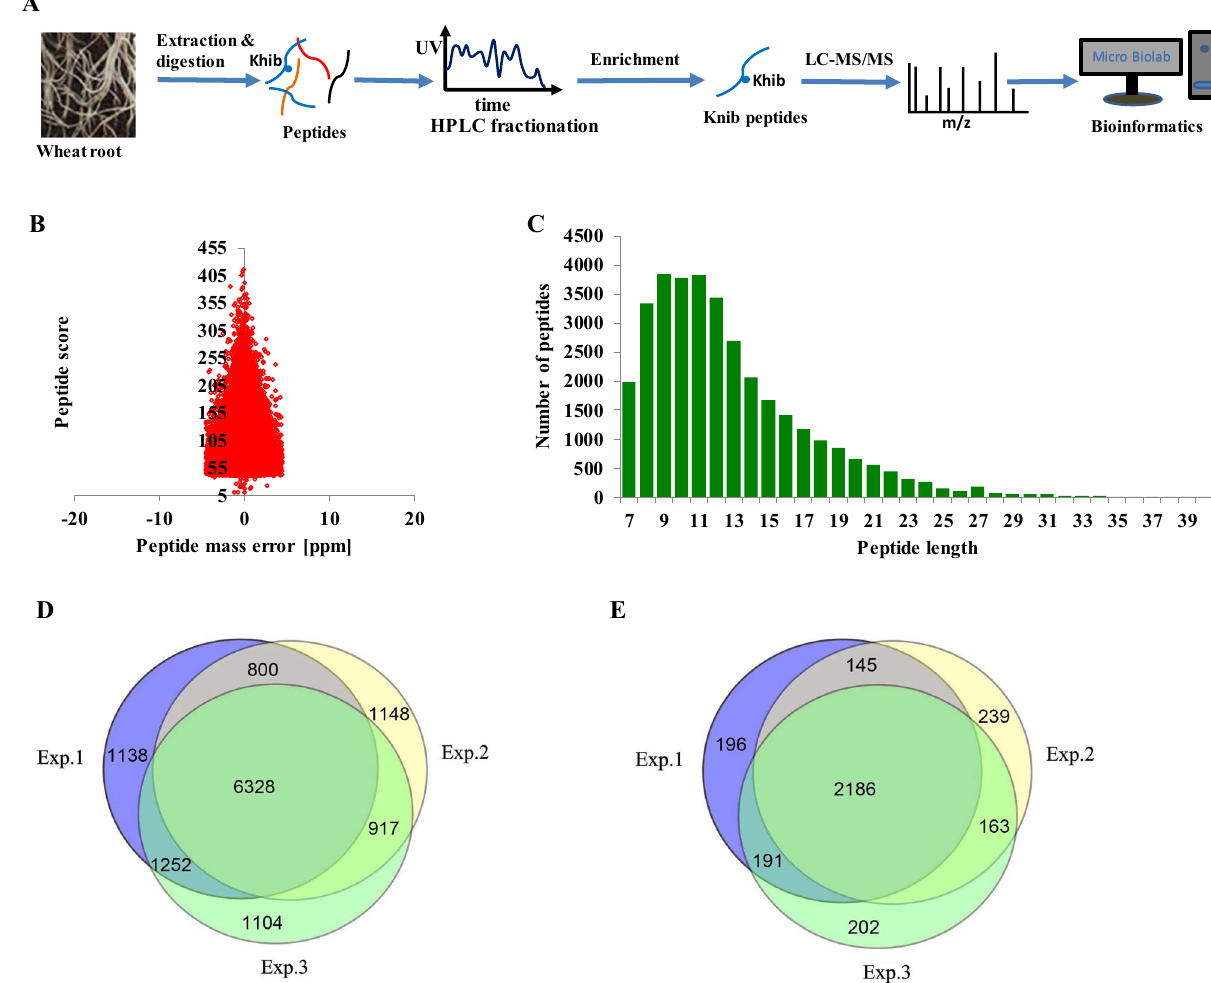
Figure 1. Systematic analysis of Khib in wheat roots. ( A ) Workflow for global Khib screening in wheat roots. ( B ) Mass error distribution of all the Khib peptides. ( C ) Peptide length distribution of all the Khib peptides. ( D ) Venn diagram of the identified Khib sites. ( E ) Venn diagram of the identified Khib